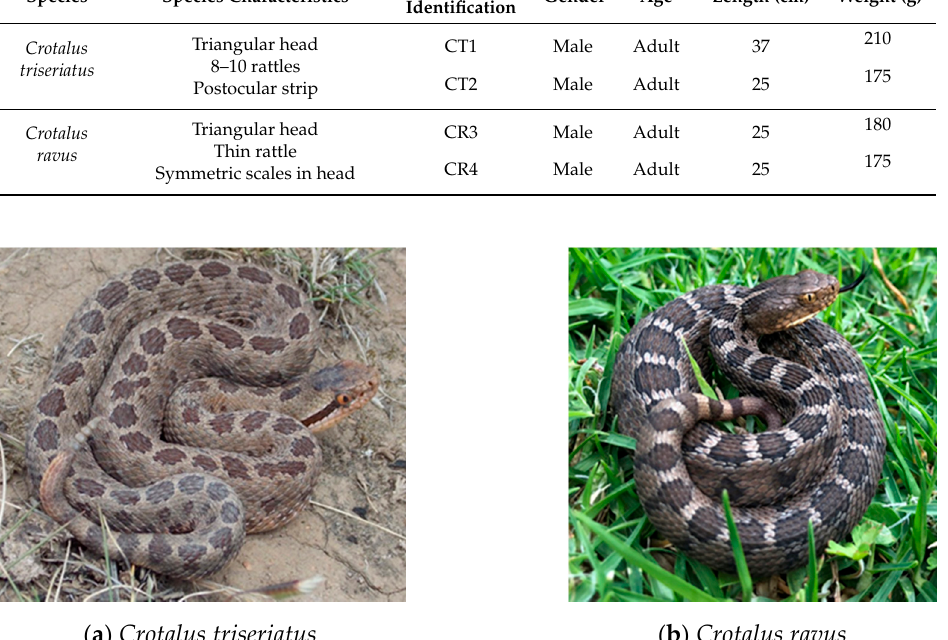
Figure 1. Captured species ( a ) Crotalus triseriatus and ( b ) Crotalus ravus.